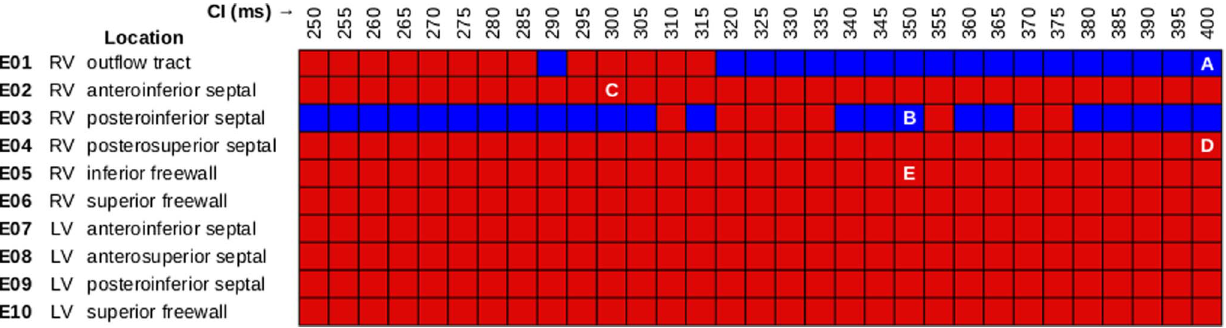
Figure 2. Vulnerability to induction of sustained arrhythmia by 310 ectopic stimuli from 10 different PVC sites (E1–E10) at 30% I Na level and arrested sinus activation. See text for further detail. Specific simulations with activation patterns and/or V m maps shown in Figs. 3, 5, or 6 are indicated by white text.